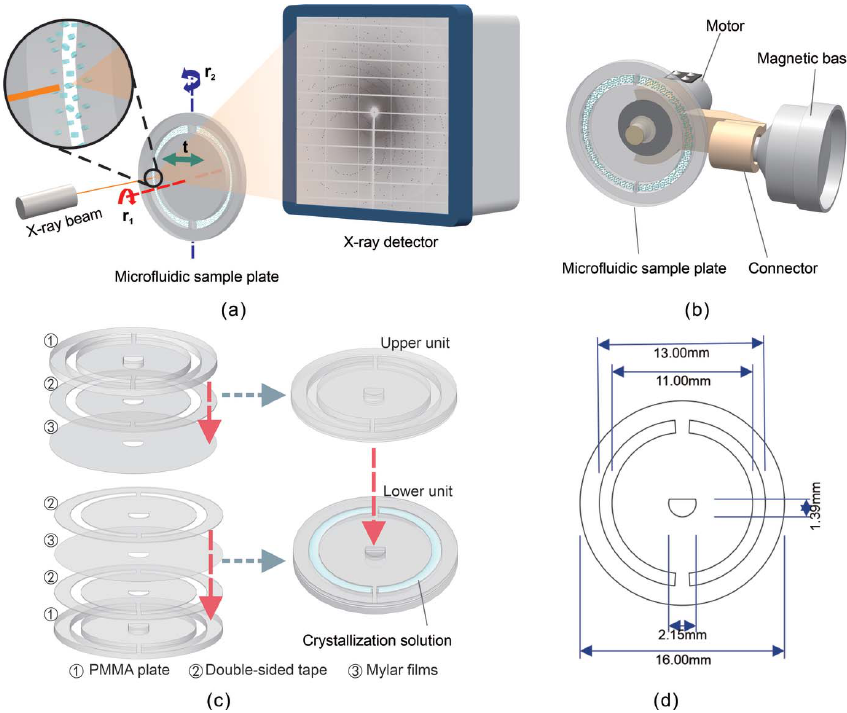
Figure 1 Design of the 3-DOF-MRT device. ( a ) Overall design of the 3-DOF-MRT device. r 1 : rotational degree of freedom; t : translational degree of freedom; r 2 : rotational degree of freedom. ( b ) Schematic diagram of the overall exterior of the 3-DOF-MRT device. ( c ) Structure and assembly process of the microfluidic sample plate. ( d ) Size of the microfluidic sample